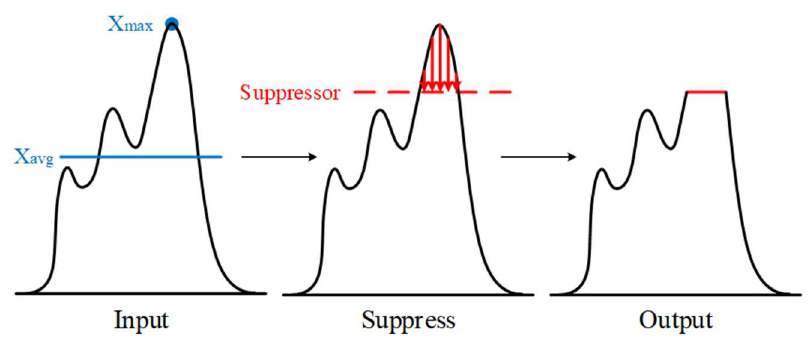
Figure 3. Suppression control operation.